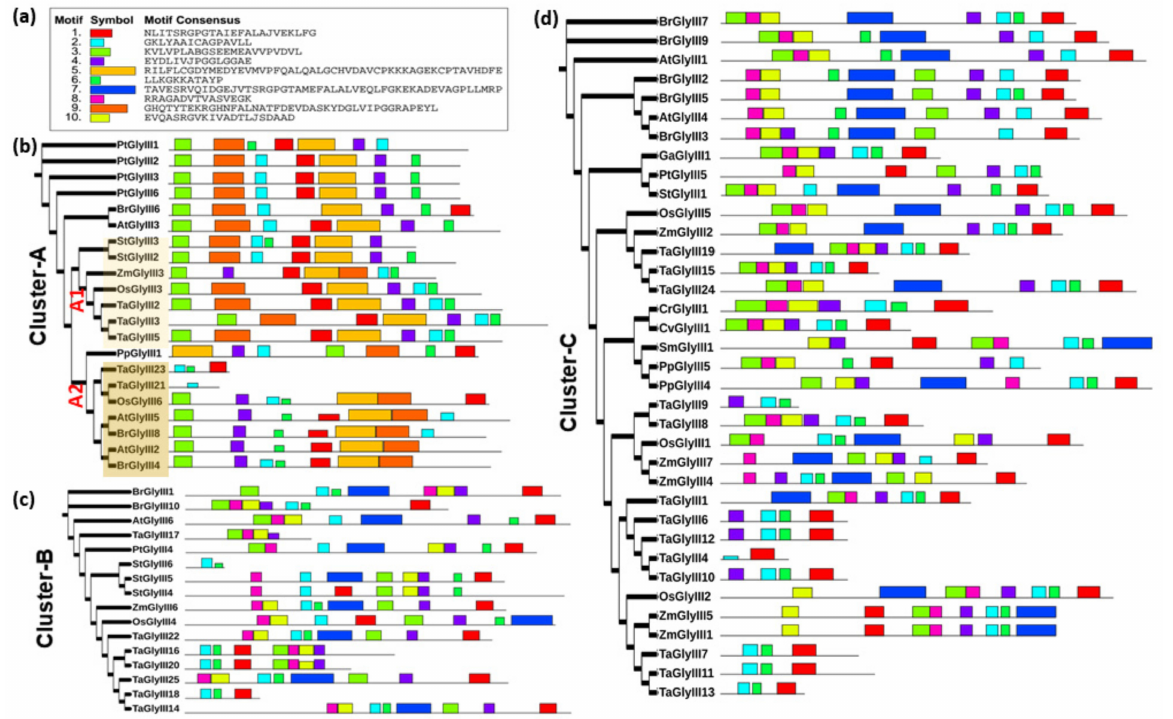
Figure 5. Extensive motif rearrangements have occurred during evolution of plant GLYIII proteins. ( a ) List of conserved motifs predicted in plant GLYIII proteins. Block diagram depicting motif organization in ( b ) Cluster-A, ( c ) Cluster-B, and ( d ) Cluster-C proteins. Conserved motifs in 73 GLYIII protein sequences from different plant species and green algae were predicted using MEME